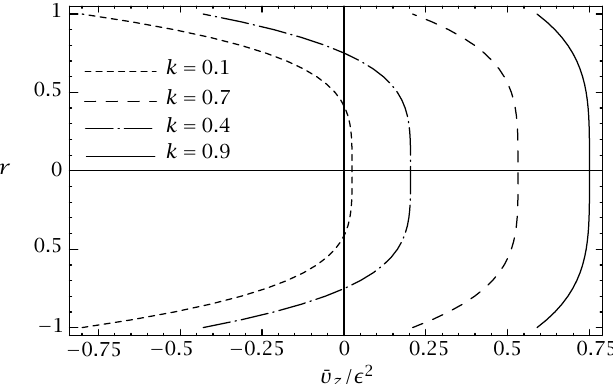
Figure 5.3 The effect of Poiseuille parameter k on the mean-velocity distri- bution and reversal flow at Re = 5 . 0 and (cid:23) = 0 .